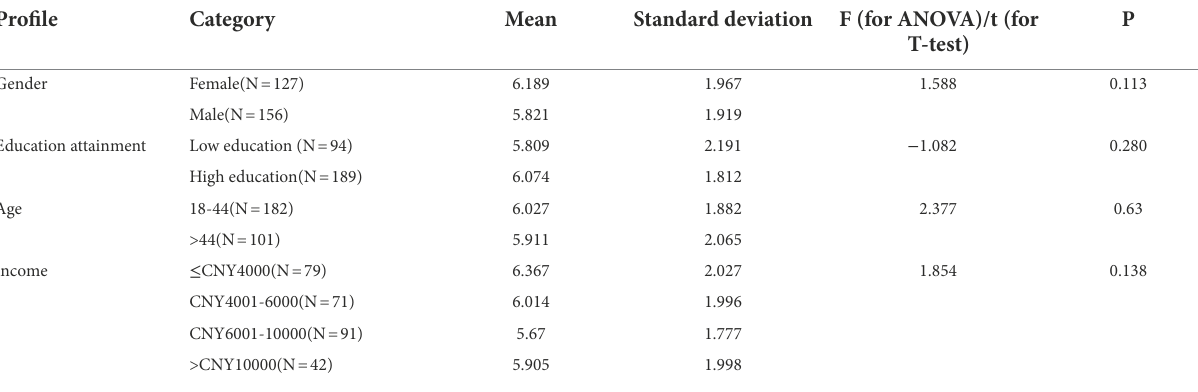
TABLE 5 Test results of the difference of demographic characteristics on public acceptance. (High perceived stress group samples). Profile